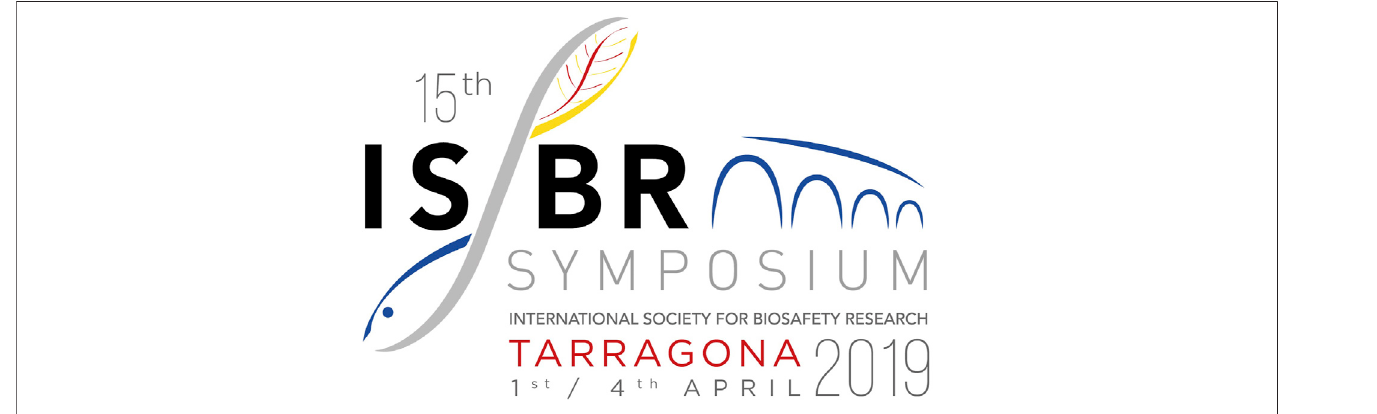
FIGURE 1 | The 15th ISBR Symposium was held in April 2019 in Tarragona,